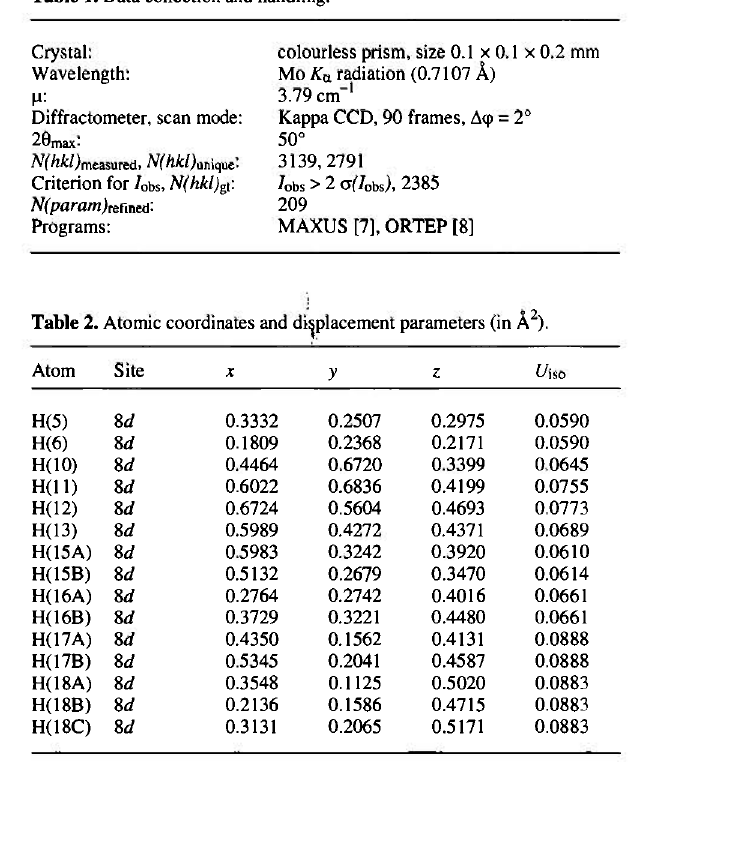
Table 1. Data collection and handling.